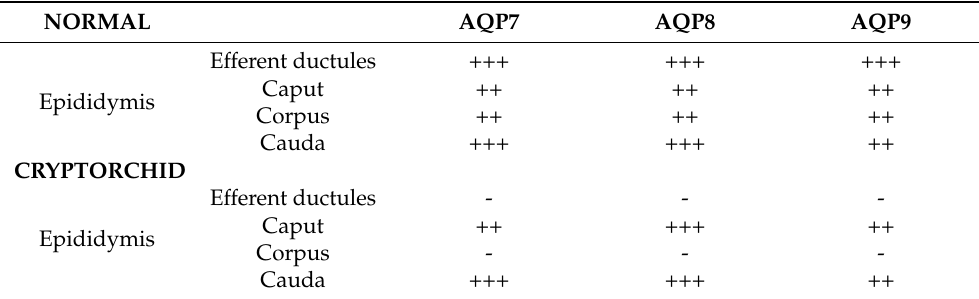
Figure 3. Immunohistochemical staining of AQP9 in normal and cryptic efferent ductules and epididymal segments. In the normal dogs, AQP9 IR was described in ( A ) cytoplasm of the efferent ductules epithelium (arrows) and ( B , D ) the apical cytoplasm (arrowheads) of the caput and cauda epididymis. Intranuclear IR was also observed for AQP9 in all epididymal segments ( B – D ). ( E , F ) A very faint immunoreactivity was detected in the apical portion of the principal cells in the caput and cauda segments of the cryptorchid epididymis (arrowheads). Bar: 25 micron. Table 2. Distribution of AQP7, 8, and 9 IRs in the efferent ductules and epididymis of normal and cryptorchid dogs.